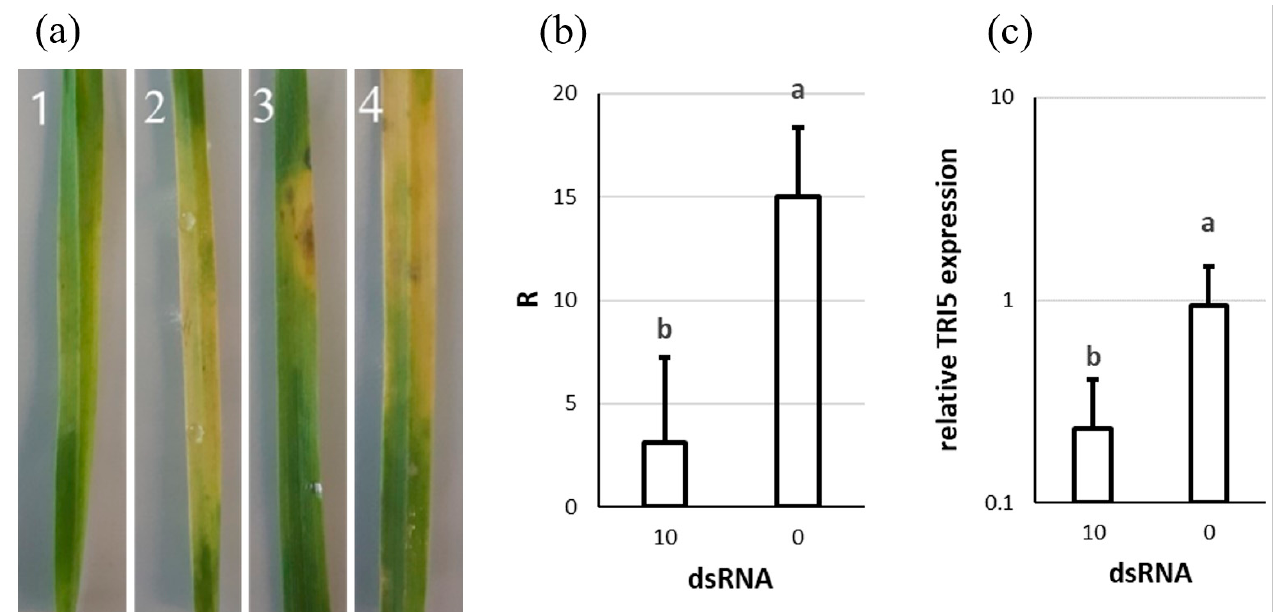
Figure 5. The effect of dsTRI5RNA-spraying on F. culmorum growth on detached wheat leaves. ( a ) Pictures of representative leaves: 1: Zlata + dsTRI5RNA, 2: Zlata + water, 3: Ivolga + dsTRI5RNA, 4: Ivolga + water. ( b ) Quantification of F. culmorum in the leaves based on EF1A relative to wheat Act . R calculated with formula (2). ( c ) Expression of the TRI5 gene in F. culmorum growing on the leaves. Expression is relative to the control sample, using EF1A as a reference gene. 0: water, 10: amount in µg of dsRNA. The graph shows the means and standard deviations of at least four biological replicates, or eight leaves. Letters above the columns indicate statistical significance; p -value ≤ 0.05.